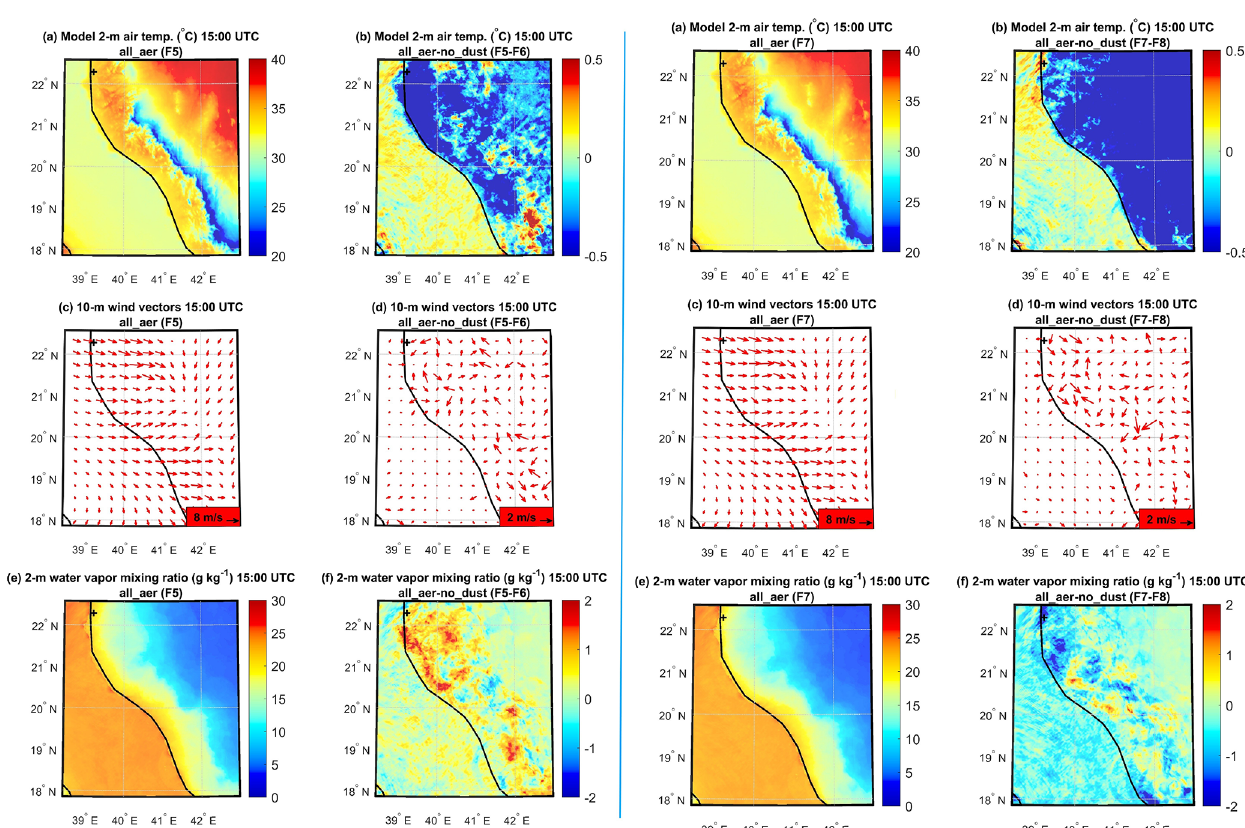
Figure 14. The left two columns show spatial patterns of 2m air temperature (a, b) , 10m wind vectors (c, d) , and 2m water vapor mixing ratio (e, f) averaged at the time of sea breeze maxima (15:00UTC) throughout the period of 4–31 August 2015 from the direct-effects-only experiment for all_aer case F5 (a, c, e) and the difference all_aer-no_dust F5 − F6 (b, d, f) . The right two columns show the same as the left two columns but without shortwave absorption, showing all_aer case (F7) and the difference all_aer-no_dust (F7 − F8).